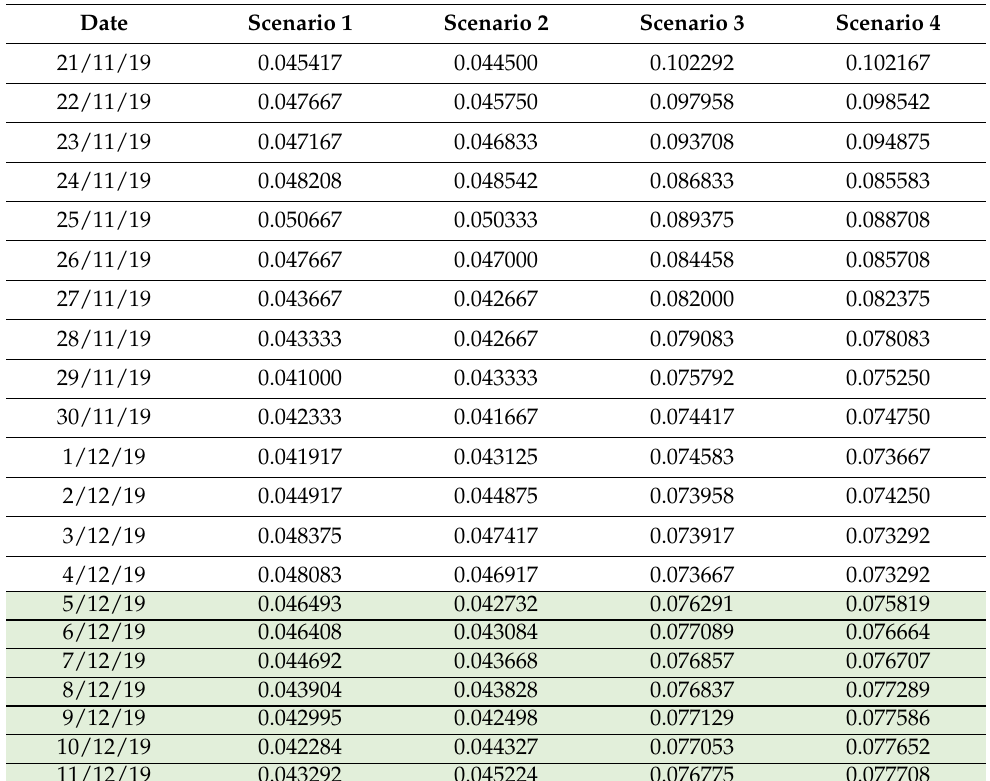
Fisher table: F2.27 (5%) = 3.35–0.532;